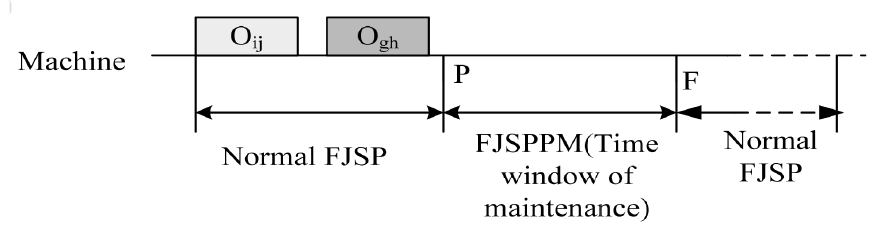
Figure 1. Dynamic FJSPPM with